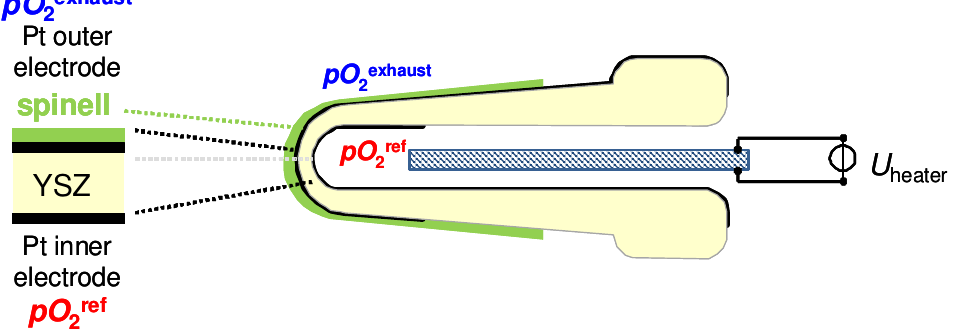
Figure 1. Cross section of a thimble type lambda probe.